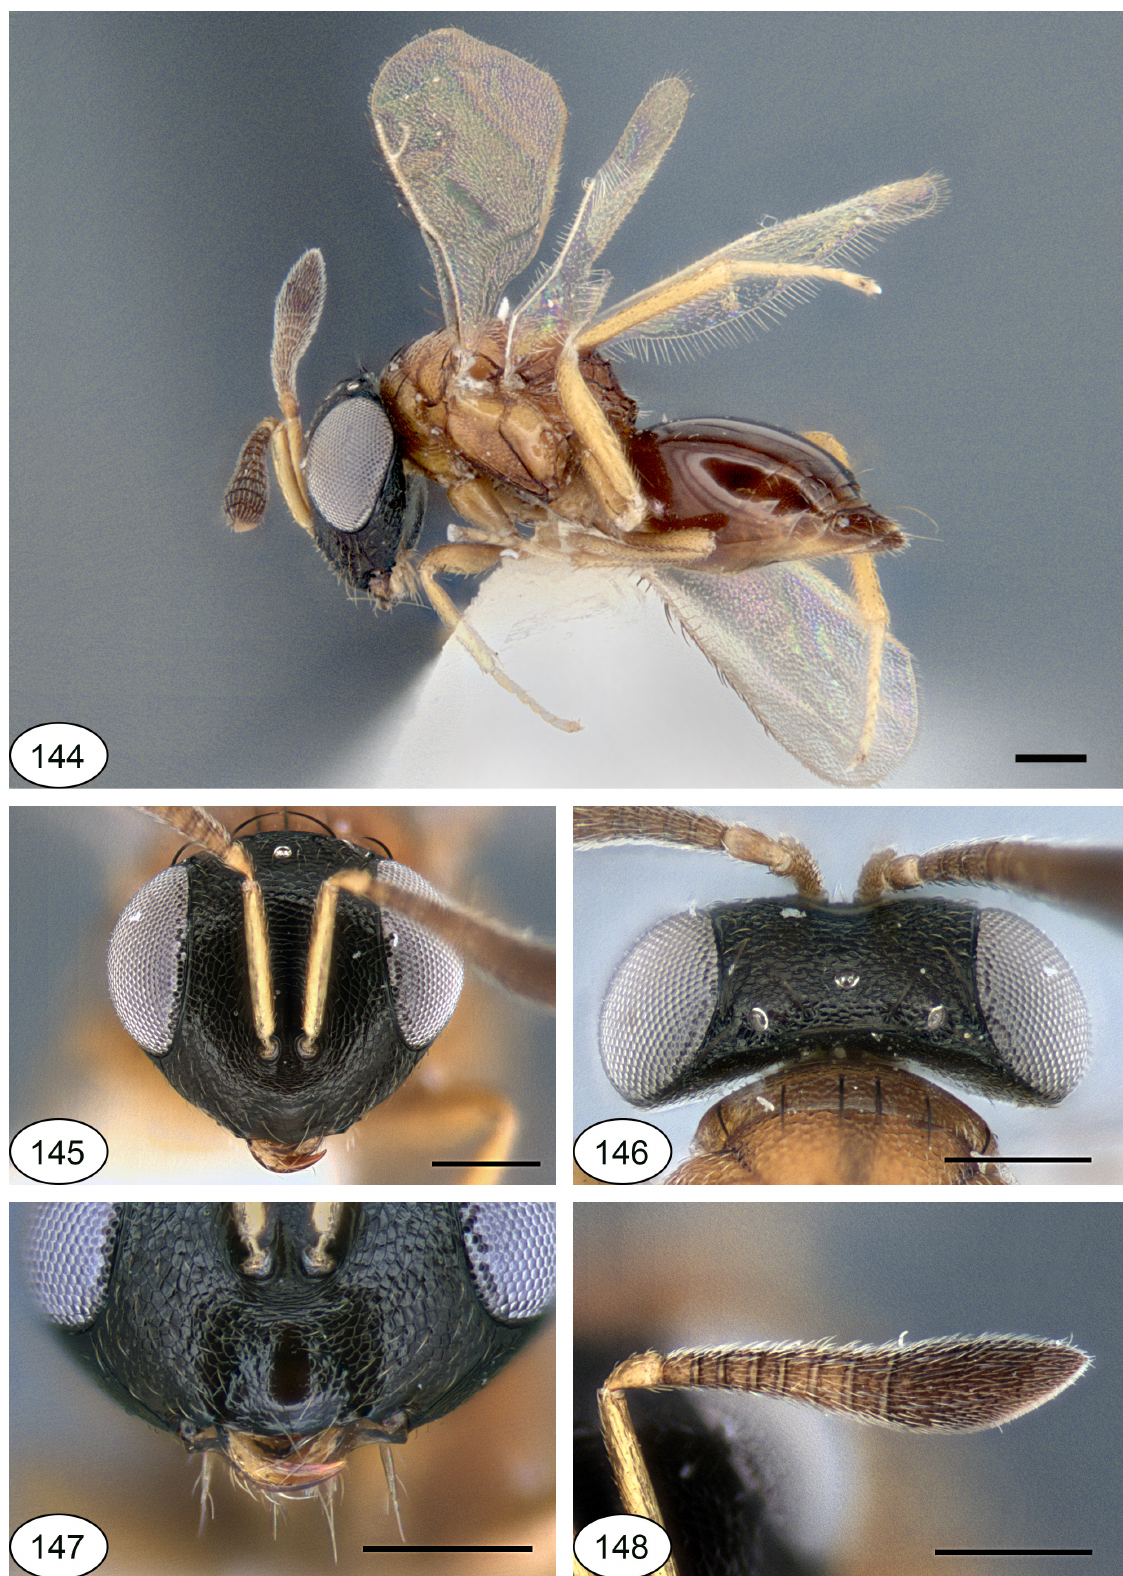
Figs 144–148. Netomocera ramakrishnai Sureshan, 2010, ♀, Taiwan. 144 . Habitus, lateral view. 145 . Head, frontal view. 146 . Head, dorsal view. 147 . Lower face. 148 . Antenna. Scale bars: 0.2